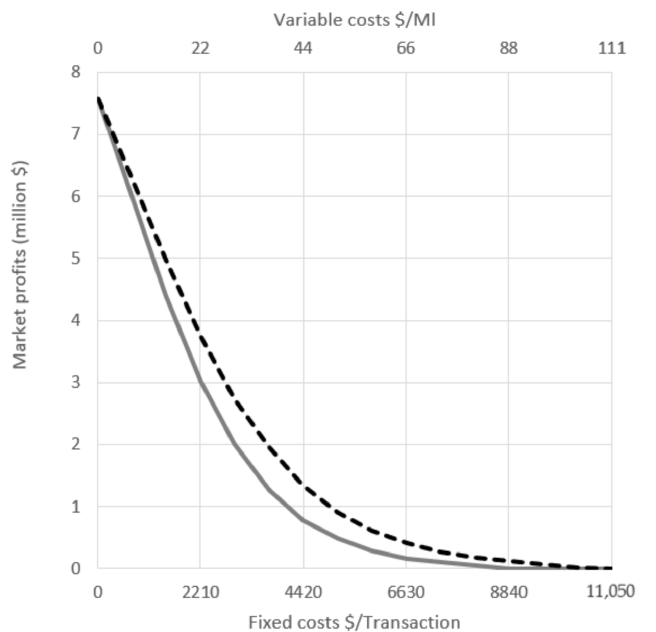
Figure 5. Transaction costs and market profits. Relationship between fixed (solid line) and variable (dotted line) transaction costs and market